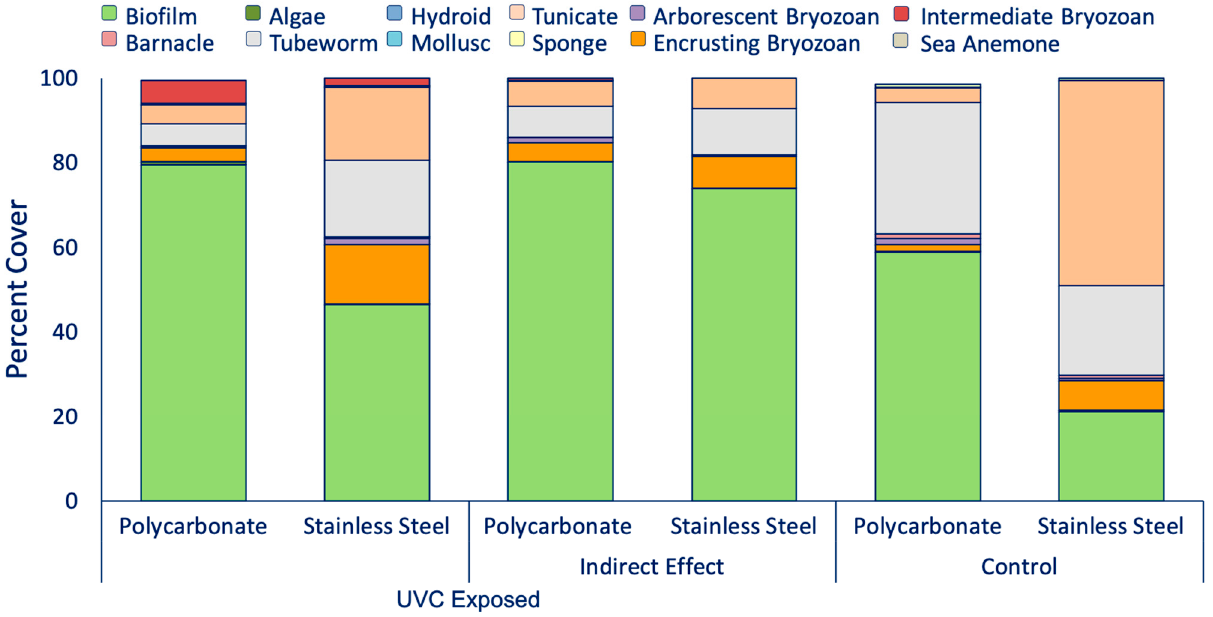
Figure 5. Biofouling composition on the UVC-exposed polycarbonate (red) and stainless steel panels and their correspond- ing controls.